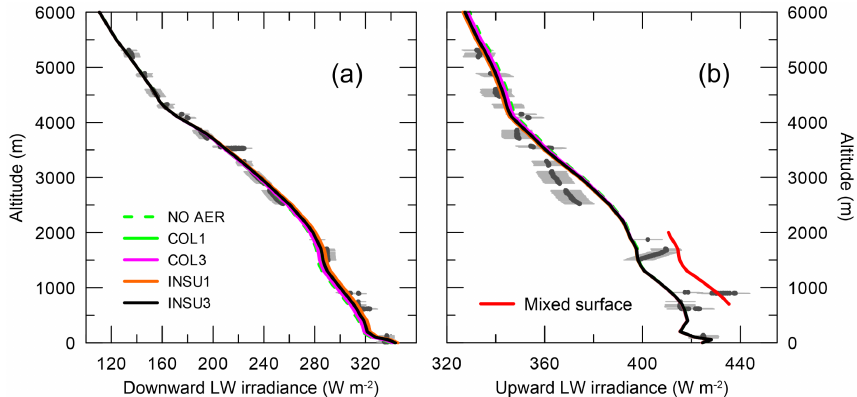
Figure 8. Same as Fig. 6, but for profile F38. The red curve in the upward LW irradiance plot is obtained using Lampedusa surface tempera- ture and emissivity. See text for